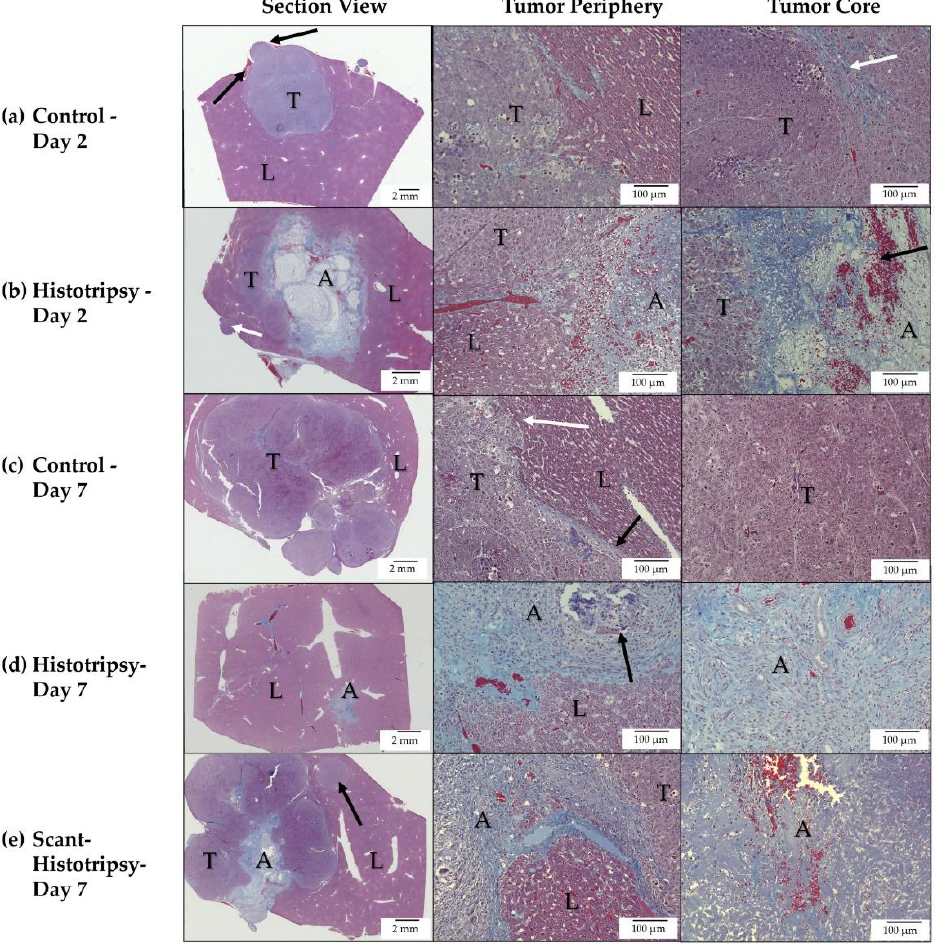
Figure 5. Trichrome-stained representative images for ( a ) untreated control tumor (Day 2), ( b ) histotripsy-treated tumor (Day 2), ( c ) untreated control tumor (Day 7), ( d ) histotripsy-treated tumor (Day 7), and ( e ) scant histotripsy-treated (<25% tumor volume ablated) tumor (Day 7). All days are measured from the histotripsy-treatment timepoint. (L: Liver, A: Ablation Zone, T: Tumor). ( a ) Control — Day 2: Nodular tumor extensions from the primary nodule are observed (black arrows), areas of collagen deposition are observed in the tumor core (white arrow). ( b ) Histotripsy — Day 2: The ablation zone can be distinguished from the untreated residual tumor region. A metastatic nodule is observed (white arrow). The ablation zone consists of mostly acellular debris with scattered red and white blood cells (black arrow). ( c ) Control — Day 7: Local tumor progression of the primary tumor and multiple metastatic nodules are observed, colonizing most of the liver lobe. Tumor cells at the periphery demonstrate invasive characteristics (white arrow), at the location where a thin rim of collagenous tissue separating the tumor from normal liver is breached (black arrow). ( d ) Histotripsy — Day 7: Tumor is replaced by scar tissue with areas of dystrophic calcification (black arrow), substantial infiltration of inflammatory cells, and few red blood cells. No viable tumor cells are observed. ( e ) Scant Histotripsy — Day 7: Local tumor progression of the primary tumor and a metastatic nodule (black arrow) are observed with an area of scar tissue within the ablation zone. The ablation zone contains red blood cells and collagen. Inflammatory cells are observed mainly at the periphery of the ablation zone, but not at the core of the ablation zone.